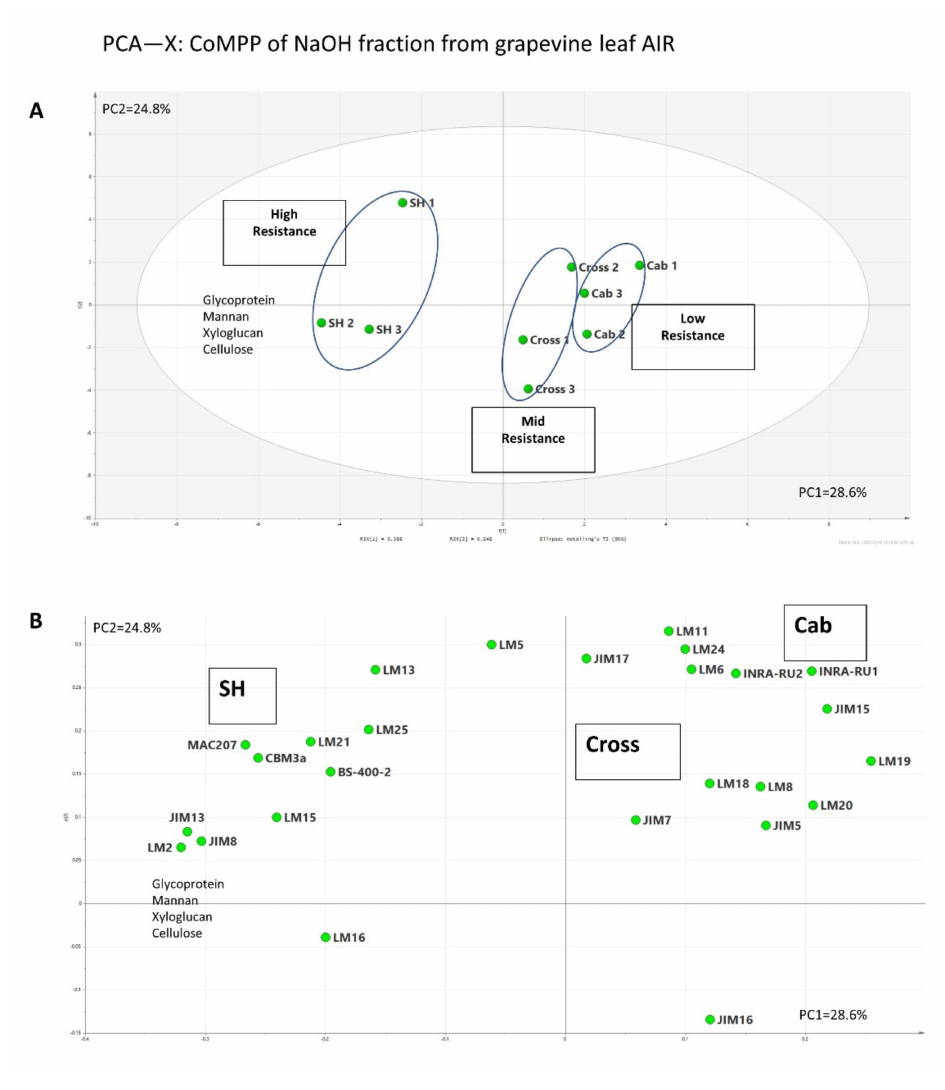
Figure 5. PCA score plot ( A ) and loading plot ( B ) of the NaOH (hemicellulose-rich) extract from AIR sourced from grapevine